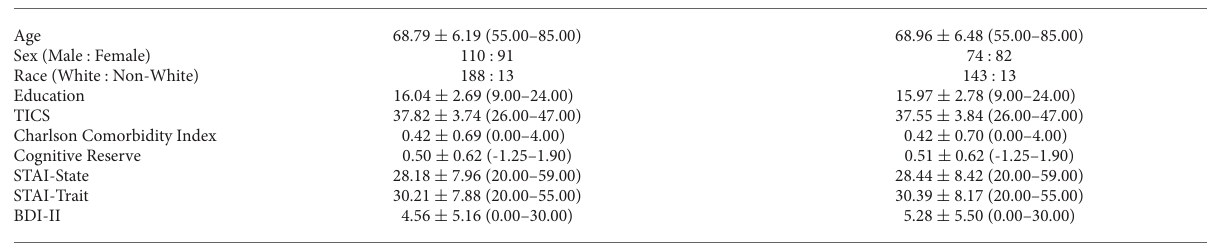
TABLE 2 Participant